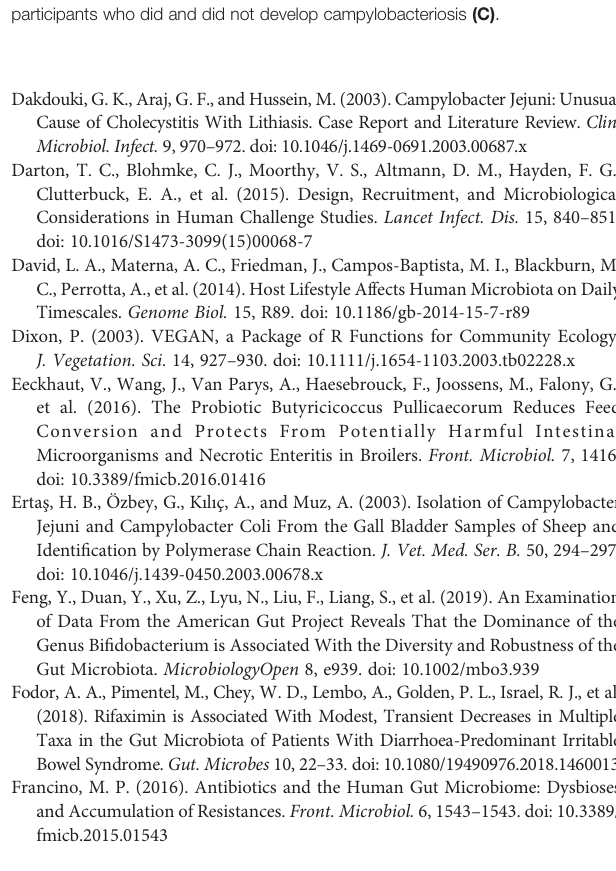
number of observed ASVs is shown on the y-axis.